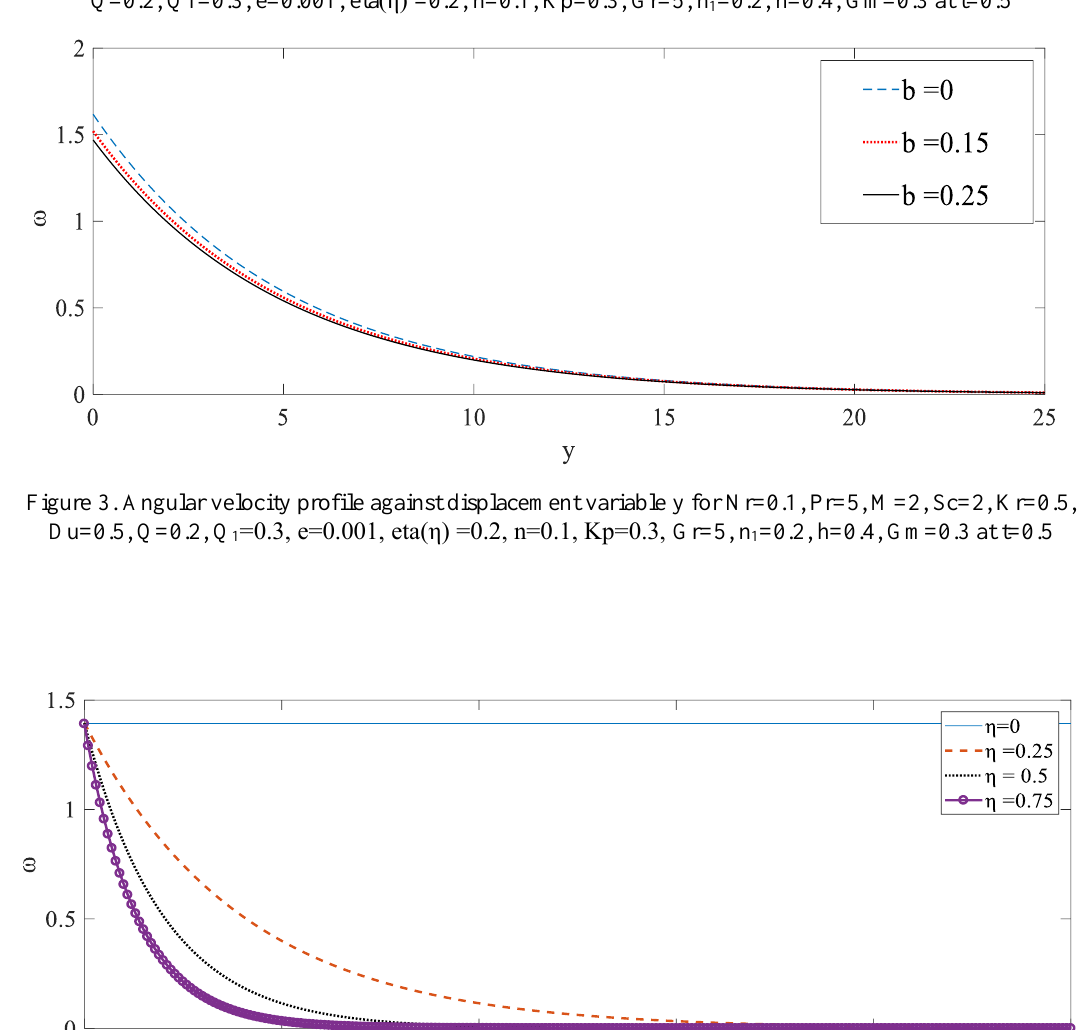
Figure 2. Velocity profile against displacement variable y for Nr=0.1, Pr=5, M=2, Sc=2, Kr=0.5, Du=0.5, Q=0.2, Q1=0.3, e=0.001, eta(η) =0.2, n=0.1, Kp=0.3, Gr=5, n 1 =0.2, h=0.4, Gm=0.3 at t=0.5